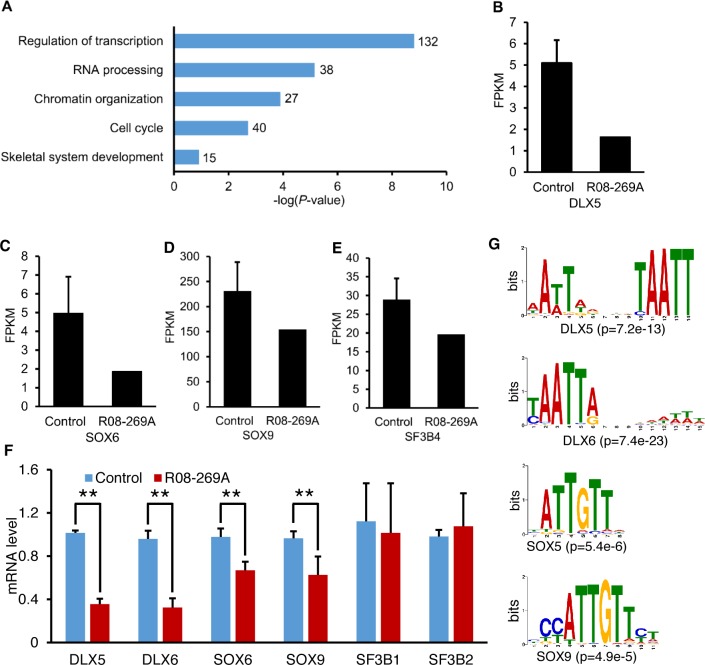
SF3B4 mutation leads to altered gene expression.(A) GO analysis of down-regulated genes in growth plate chondrocytes from case R08-269A. The number of genes in each GO term is indicated. (B-E) Expression changes of (B) DLX5, (C) SOX6, (D) SOX9 and (E) SF3B4. The gene expression is represented as FPKM values. (F) Real-time quantitative RT-PCR validation of the RNA-seq data. mRNA expression was normalized to GAPDH. **p<0.01. (G) From top to bottom, enriched DLX5, DLX6, SOX5 and SOX9 binding motifs among the promoter regions of the down-regulated genes. The p values for motif enrichment are shown in parentheses below each motif.